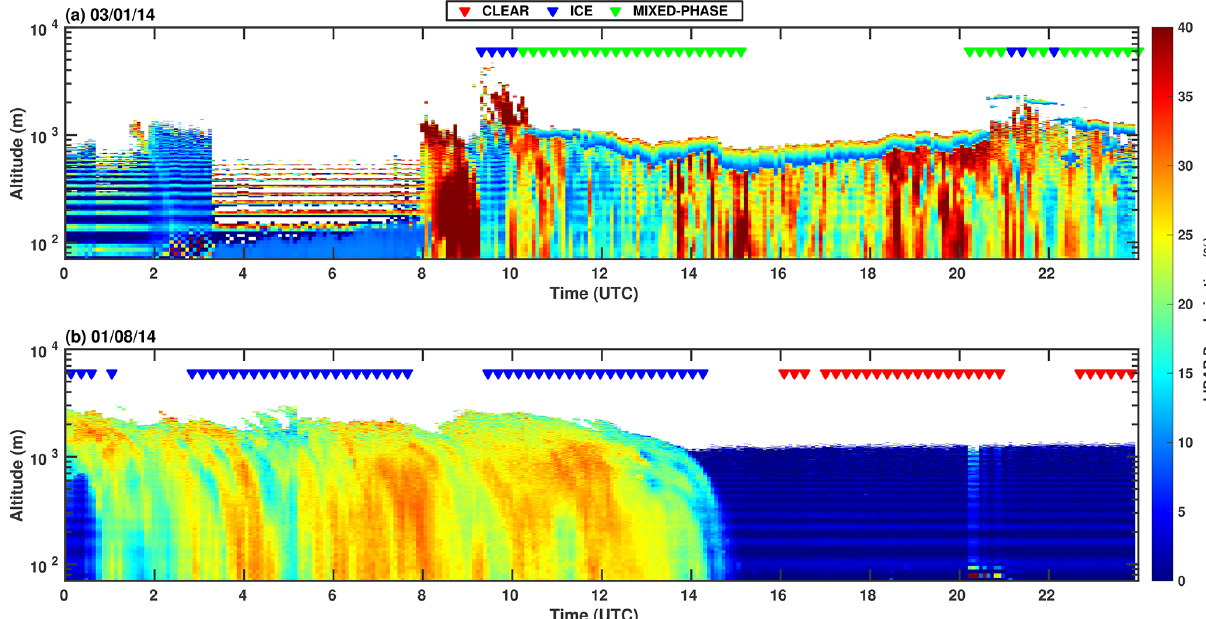
Figure 7. Lidar depolarization ratio on (a) 3 January 2014 and (b) 1 August 2014. The triangles mark the REFIR-PAD observations. The color code indicates the CIC classification: red for clear sky, blue for ice clouds, and green for mixed-phase